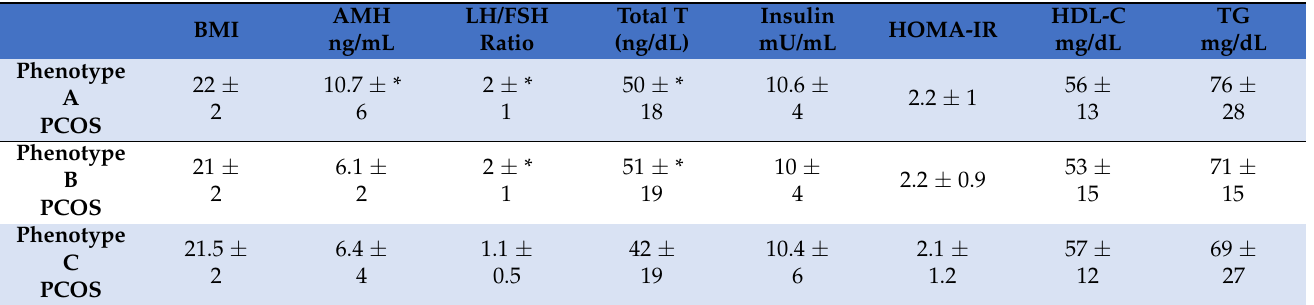
Table 4. Some hormonal and metabolic blood values in lean patients with different PCOS